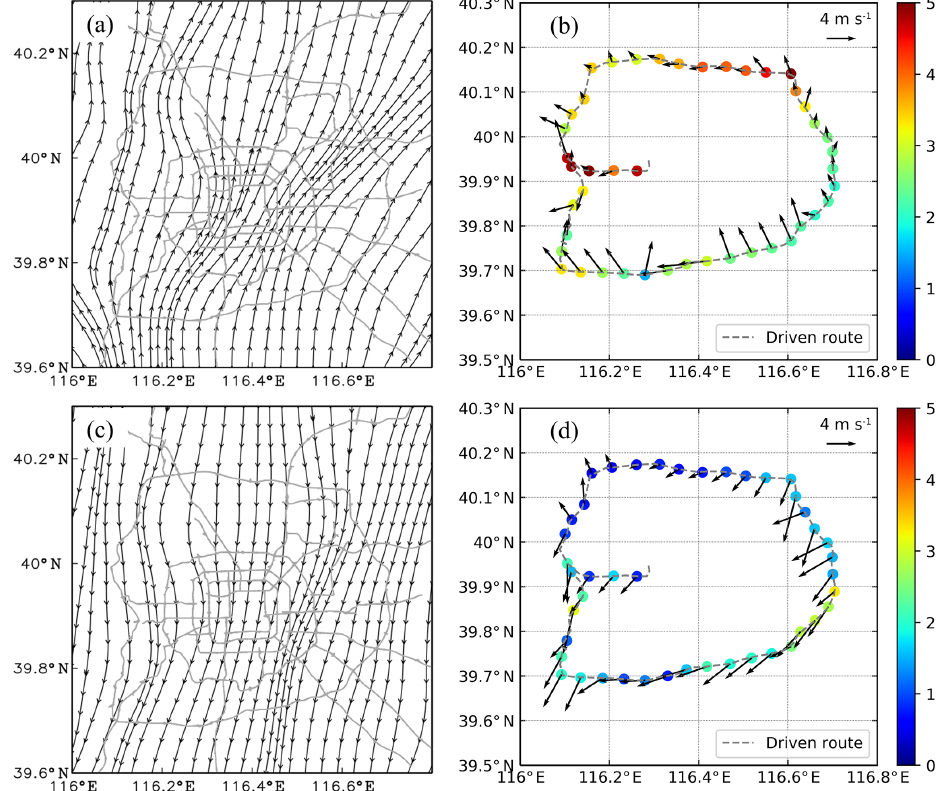
Figure 8. Average wind stream and NO 2 VCD (10 16 molec.cm − 2 ) distributions under the two different types of wind field over Beijing: (a) southerly wind, (b) NO 2 VCD under southerly wind, (c) northerly wind, and (d) NO 2 VCD under northerly